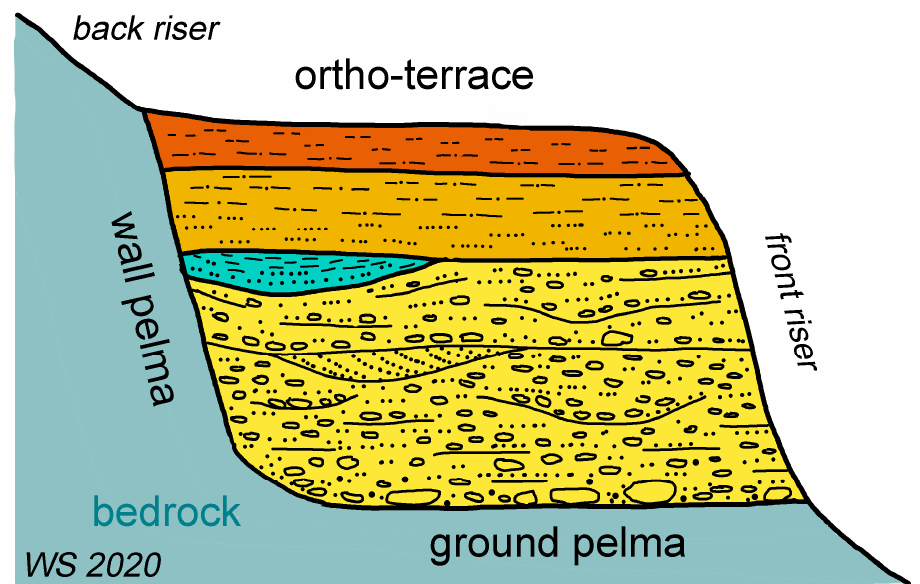
Figure 3. Ortho-terrace and pelma: A complete flument is bounded on top by the ortho-terrace as tread, at the basal bedrock contact by the ground pelma, and at the lateral bedrock contact by the wall pelma. (The flument exemplarily is figured as V ‐ flument).